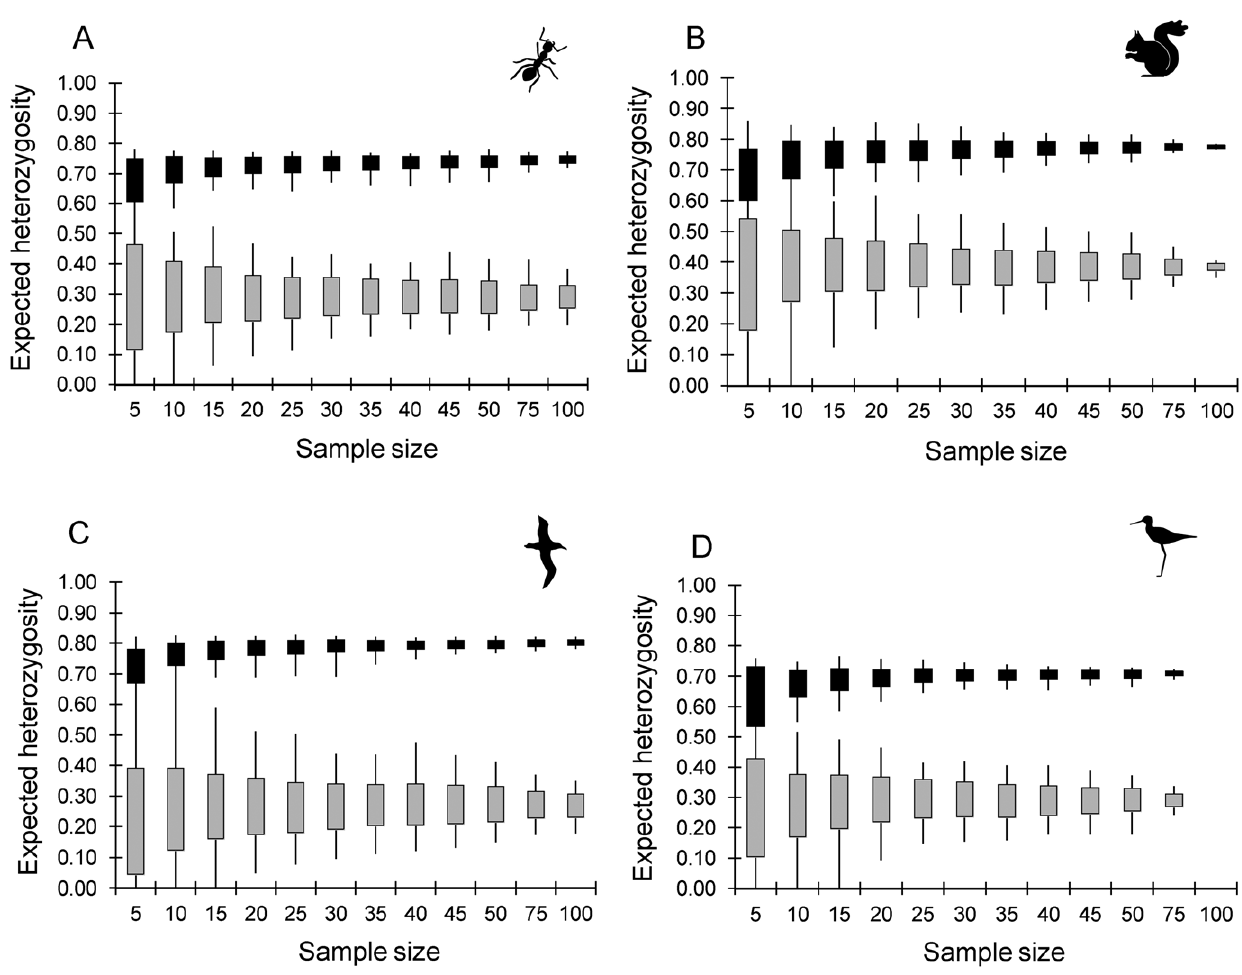
Figure 4. Impact of sample size on the accuracy and precision of sample heterozygosity. The range (lines) and mean 6 one standard deviation (solid boxes) of expected heterozygosity (H E ) for the 100 random replicates at each sample size for a locus with high and a locus with low expected heterozygosity in the empirical dataset for A) the ant dataset, B) the squirrel dataset, C) the albatross dataset and D) the kakı¯ dataset. Loci are: A) locus FE37 (real H E =0.75, black boxes) and locus FE17 (real H E =0.29, grey boxes); B) locus Scv3 (real H E =0.78, black boxes) and locus Scv23 (real H E =0.39, grey boxes); C) locus De11 (real H E =0.807, black boxes) and locus D5 (real H E =0.268, grey boxes); and D) locus Kakı¯_21 (real H E =0.712, black boxes) and locus Kakı¯_40 (real H E =0.291, grey boxes).